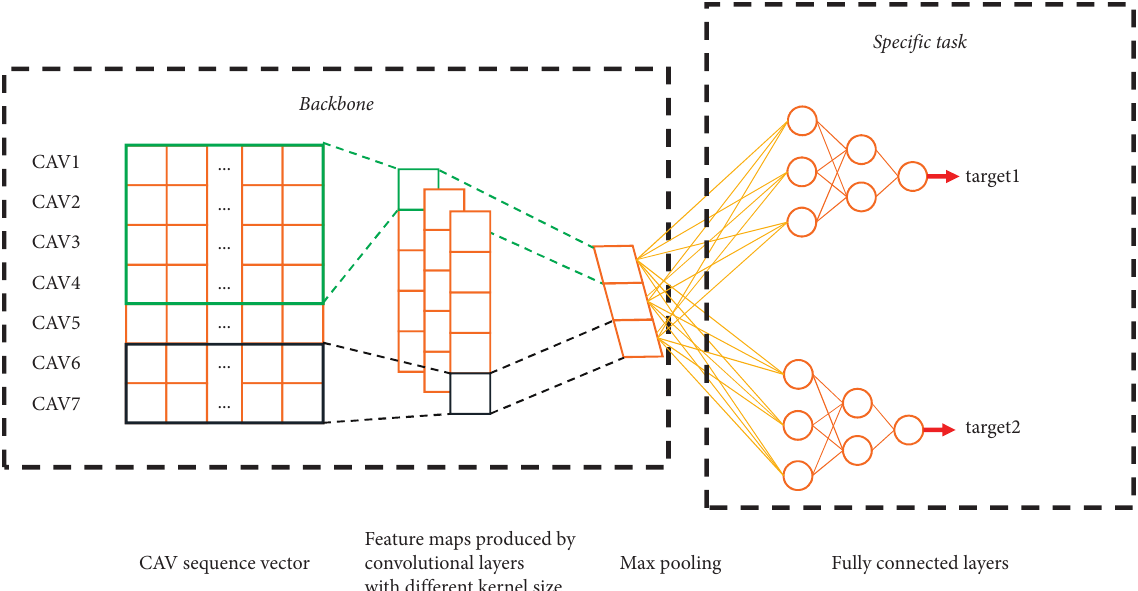
Figure 4: Structure of the proposed neural network. The backbone layer is for feature extracting, and the specific task layer is for different regression